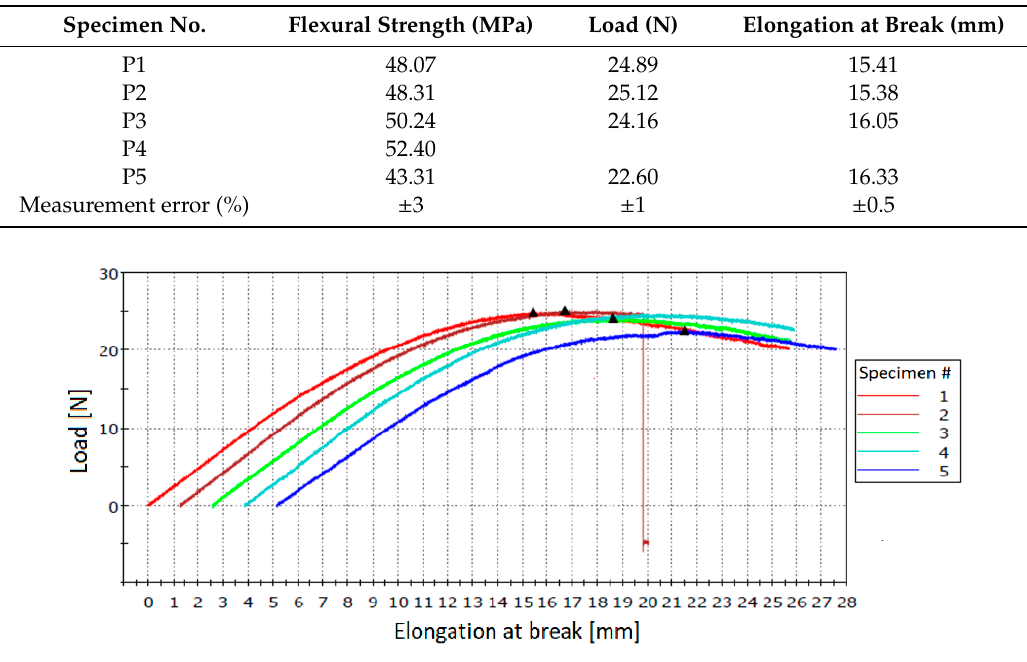
Figure 26. Stress–strain curves for PUF-DCPD specimens fabricated with method 6.